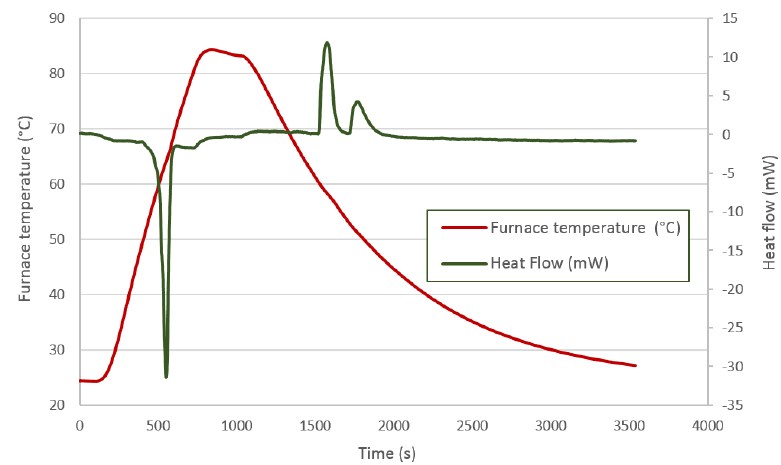
Figure 6. PT58 DSC analysis.